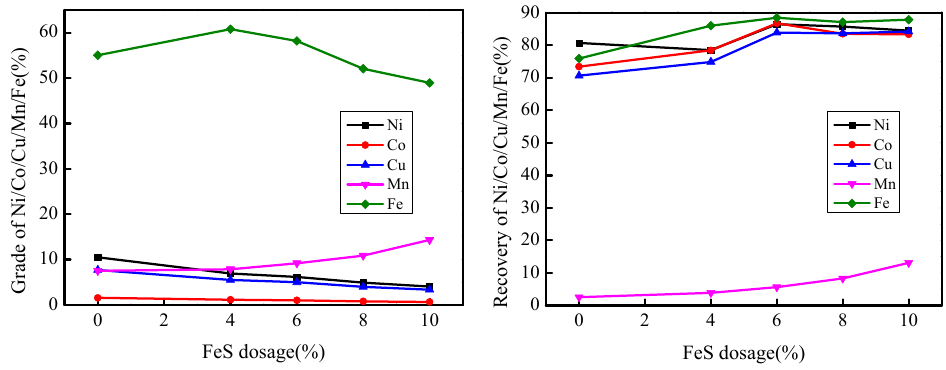
Figure 10. Effect of FeS dosage on the concentration of valuable metals.